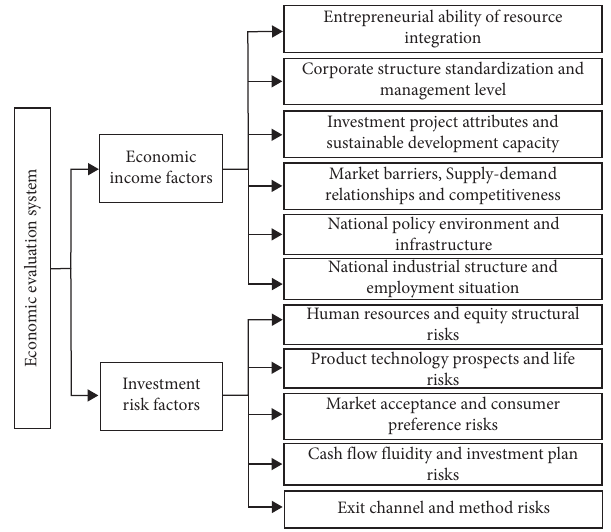
Figure 1: Contents and structure of the economic evaluation system for transnational investment